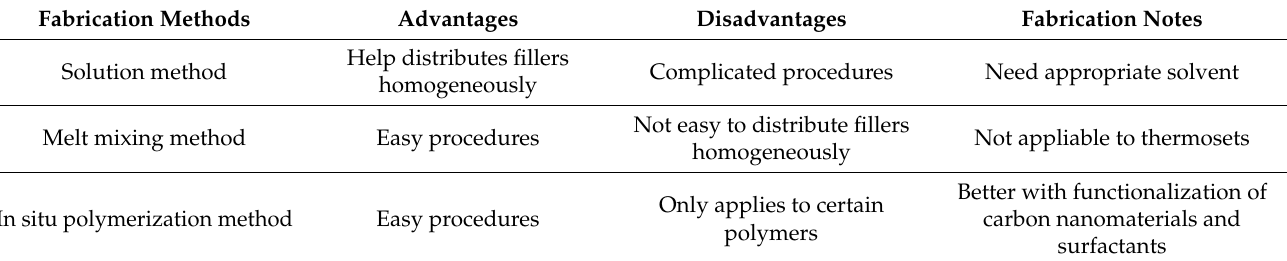
Table 8. Advantages, disadvantages, and notes of different fabrication